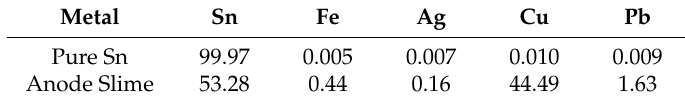
Figure 5. Electrolytic cell ( a ) and cathode (Sn deposit) ( b ). Table 5. Chemical composition (mass %) of the Sn deposited, and of the slime.